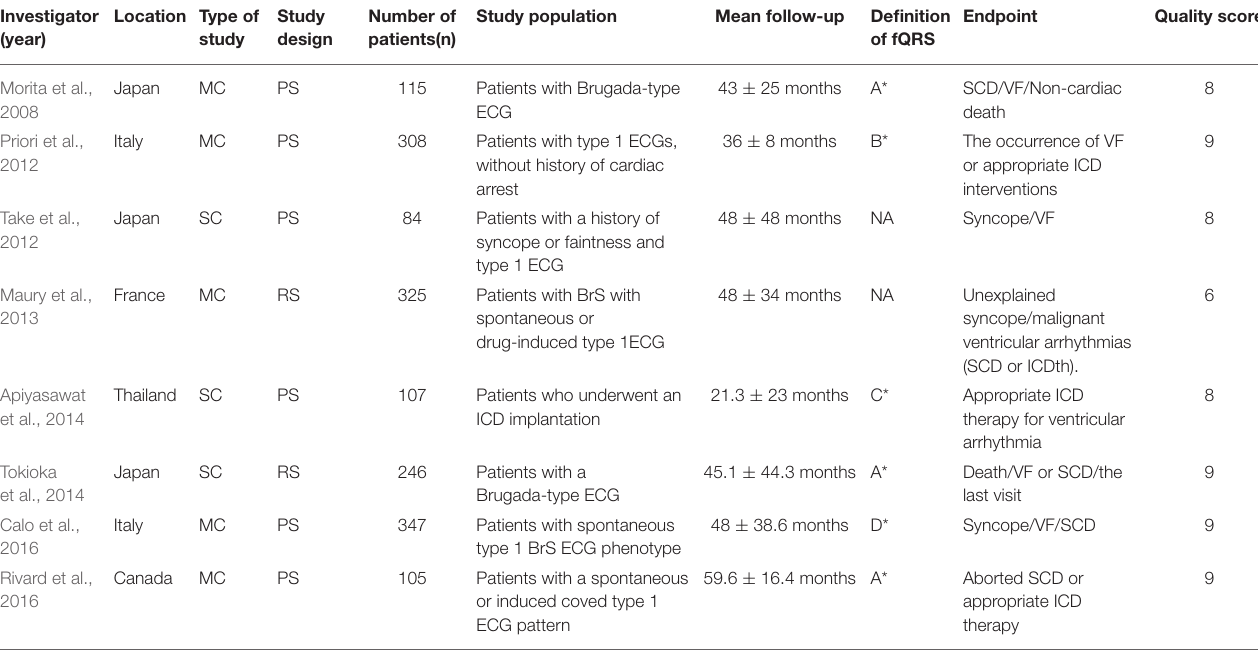
TABLE 1 | Study characteristics of eight studies included in